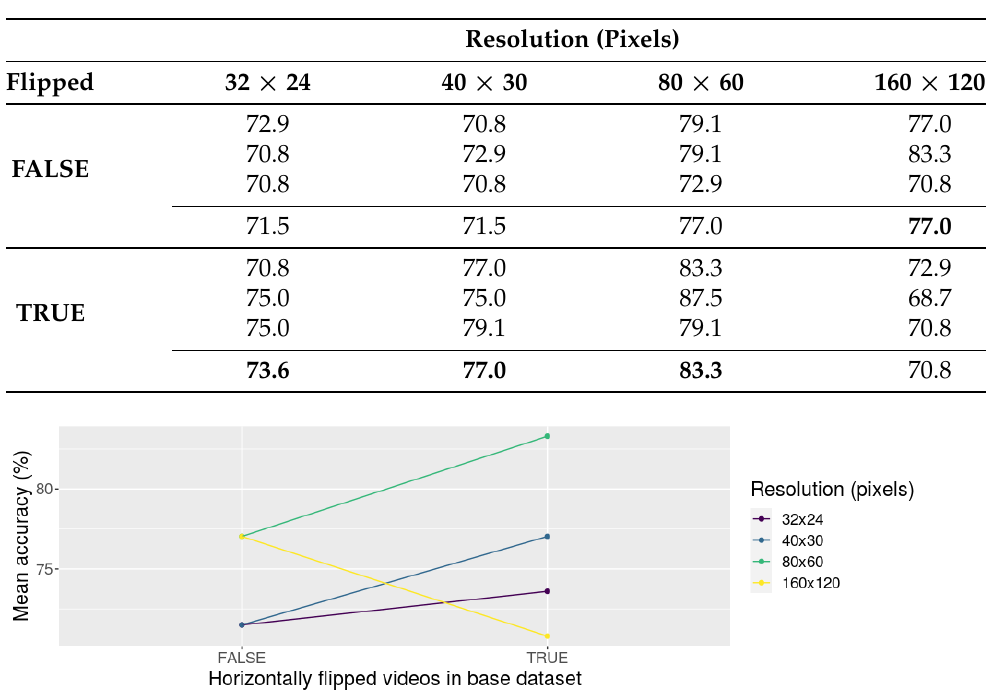
Table 5. Accuracy (%) of the models trained with the eight different configurations from experiment P04 (using 60% of the dataset for training). Each cell presents the accuracy of three independent models per configuration and its average. The best results per resolution are highlighted in bold.